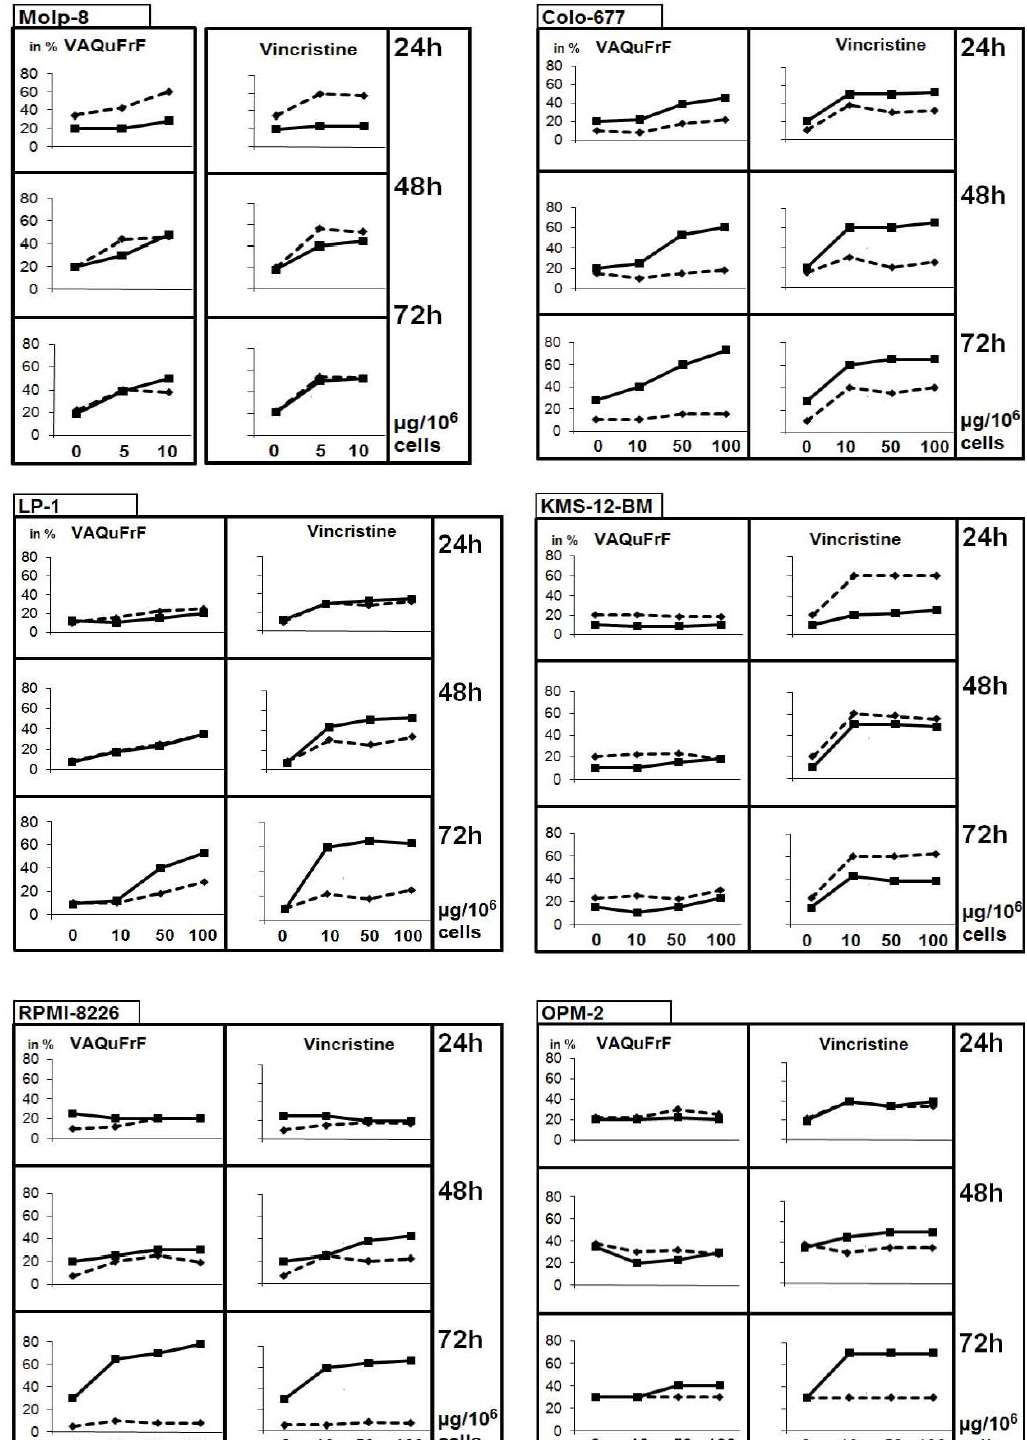
FIGURE 2 . Apoptosis and necrosis of the human multiple myeloma cell lines Molp-8, LP-1, RPMI-8226, Colo-677, KMS- 12-BM, and OPM-2. The cells were incubated with VAQuFrF or vincristine (0, 5, 10, 50, and 100  g/10 6 cells/ml) for 24, 48, and 72 h. The apoptosis was measured using Annexin V-FITC, necrosis using propidium iodide; ♦ - - - ♦ apoptotic cells, ■––■ necrotic cells. The values are the mean of three or four independent experiments, expressed as percentage of total cell